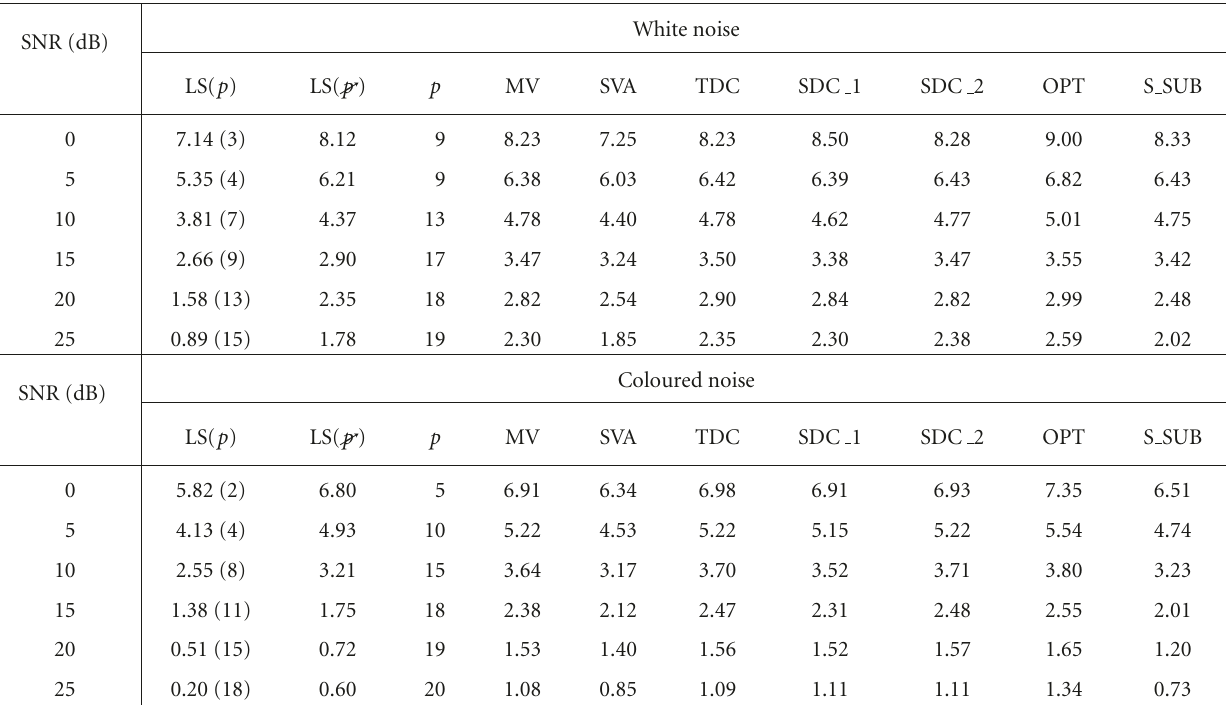
Table 1: Segmental SNR improvements (dB) with SVD-based speech enhancement. N = 480, f s =